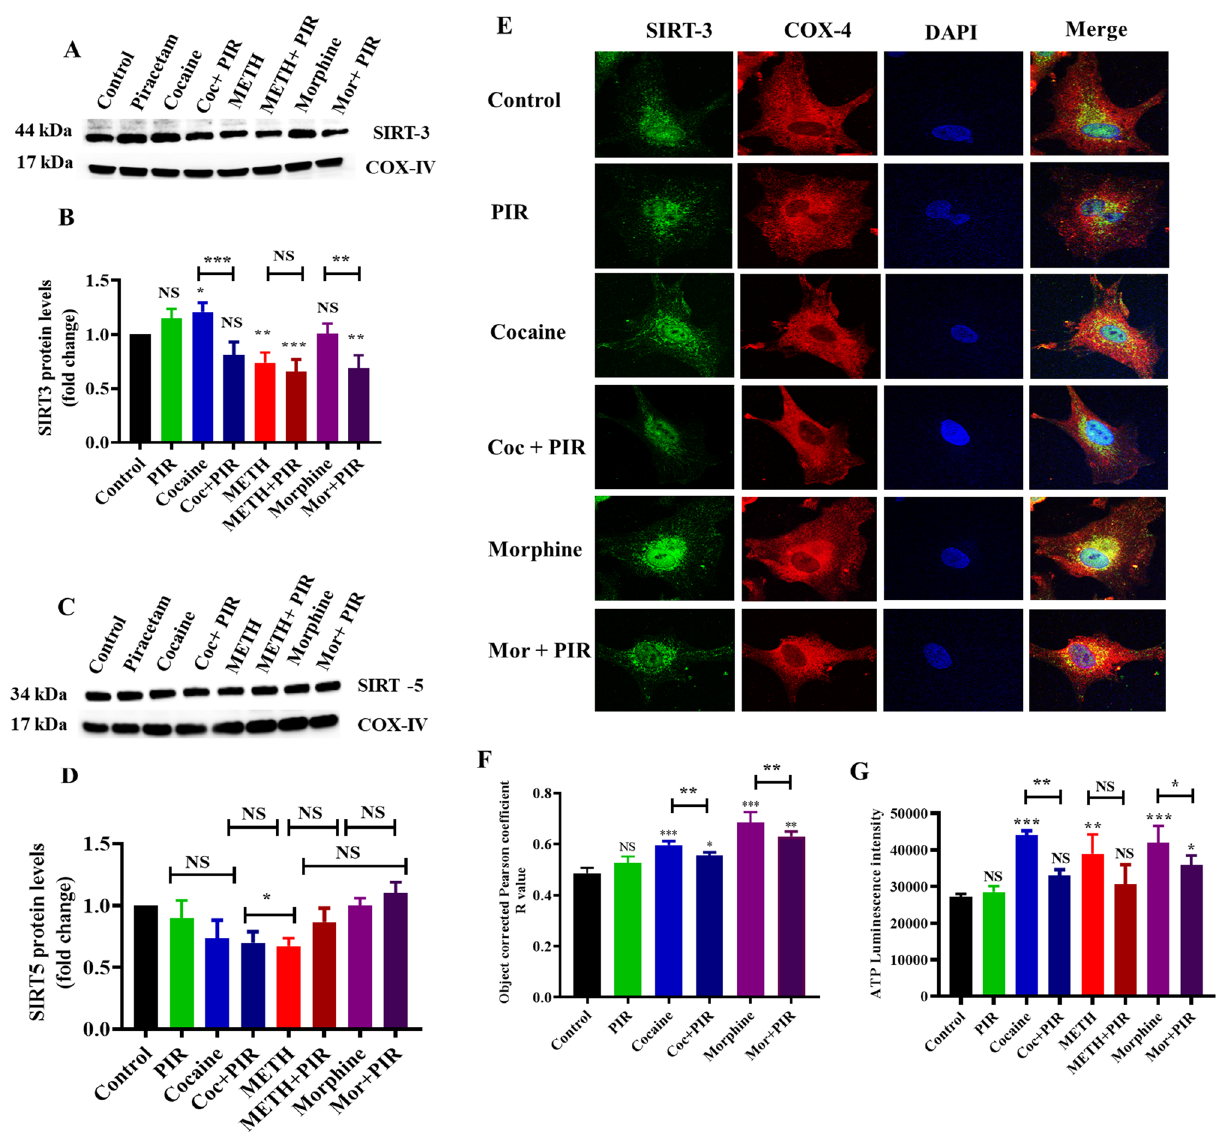
Figure 5. The protective effects of piracetam against the effects of psychostimulants and opioids on the mitochondrial protein expression of SIRT-3 and SIRT-5. Human primary astrocytes were exposed to cocaine (1 µM), METH (10 µM) and morphine (5 µM) alone or in combination with piracetam (10 µM) for 24 h to isolate the mitochondrial fraction. Controls were maintained in drug-free medium (without drug exposure). Representative blots showing the expression of mitochondrial proteins ( A ) SIRT-3 and ( C ) SIRT-5. ( B ) and ( D ) Densitometric analyses of each protein level to its corresponding COX-IV loading control (fold- change from control). Data are expressed as the means ± SD of three independent experiments. ***P < 0.001, **P < 0.01, *P < 0.05, NS—Nonsignificant. ( E ) Effects of psychostimulants and opioids on SIRT-3 expression and colocalization. SIRT-3 expression (green), mitochondrial membrane protein COX-IV (red) and nuclear stain DAPI (blue) were observed using confocal microscopy (magnification 100x, scale bar 100 μm). ( F ) Quantification of SIRT-3 colocalization with the mitochondrial membrane protein COX-IV was analyzed using Pearson’s coefficient r value in three different regions of interest (ROIs) for the same cell. ( G ) Effects of psychostimulants and opioids on intracellular ATP content. Data are expressed as the means ± SD of luminescent intensity in triplicate. ***P < 0.001, **P < 0.01, *P < 0.05, NS—Nonsignificant. Coexposure of psychostimulant or opioid with piracetam compared to psychostimulant or opioid alone. The supplementary information includes all full-length